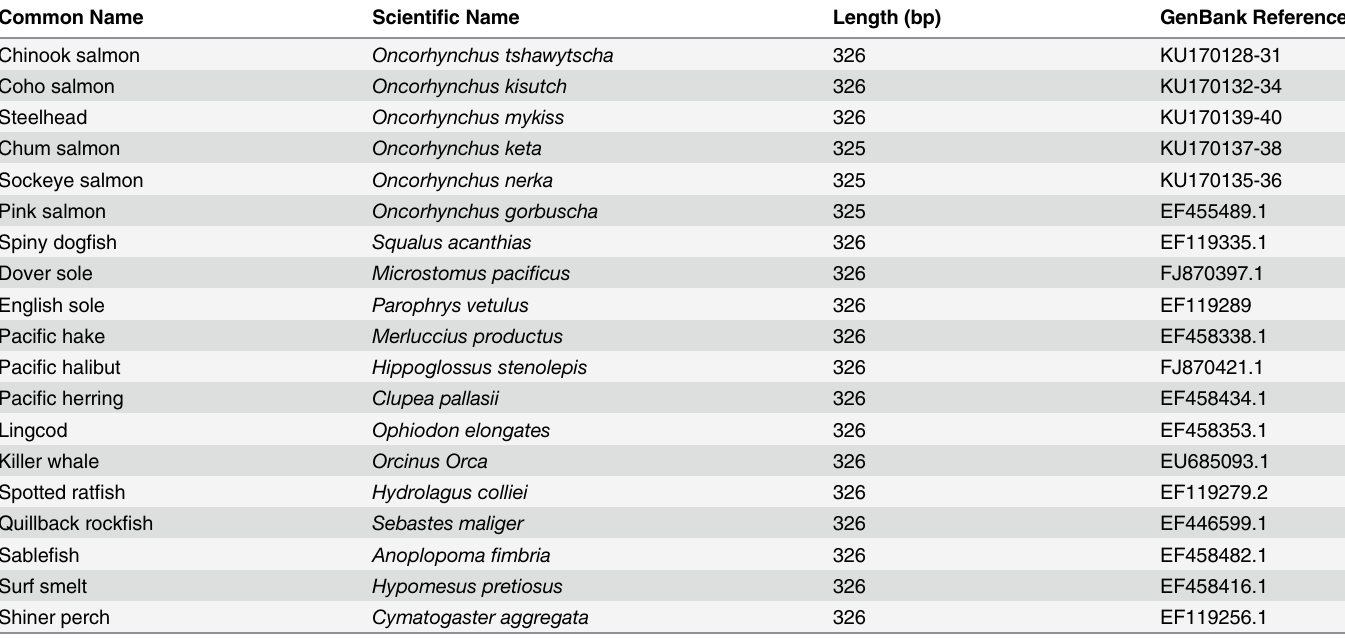
Table 2. Reference Sequences used for species